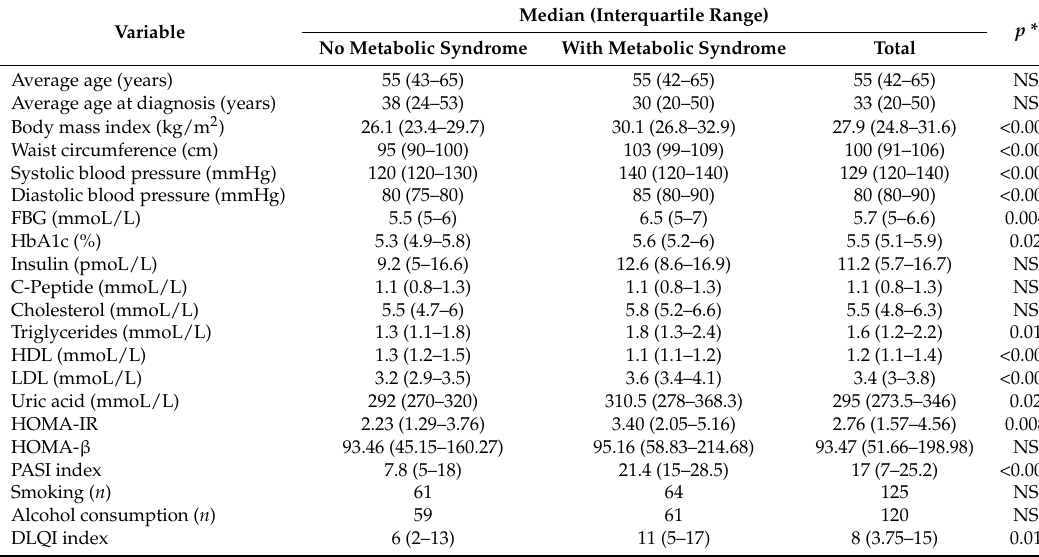
Table 1. Baseline characteristics of patients according to